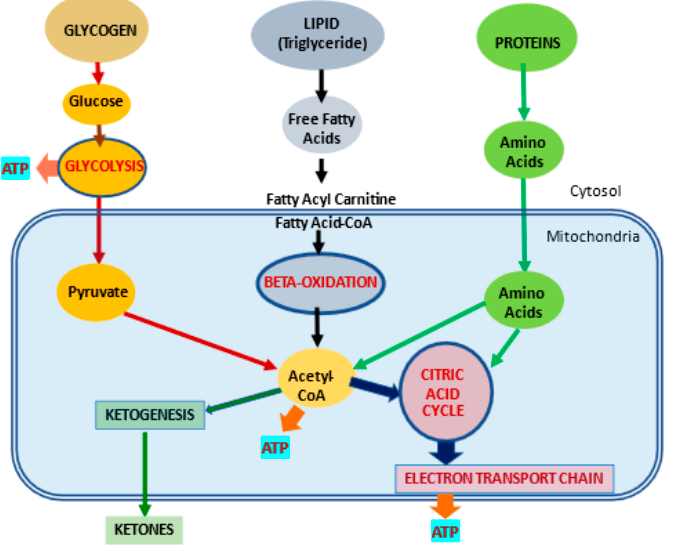
Figure 1. Metabolic pathways for major substrates in the body. Adapted from Virmani et al., 2015 [2]. The body utilizes carbohydrates as glucose, lipids as free fatty acids and proteins as amino acids as the major substrates for the production of ATP energy. Much of the energy from these substrates is produced in the mitochondria.